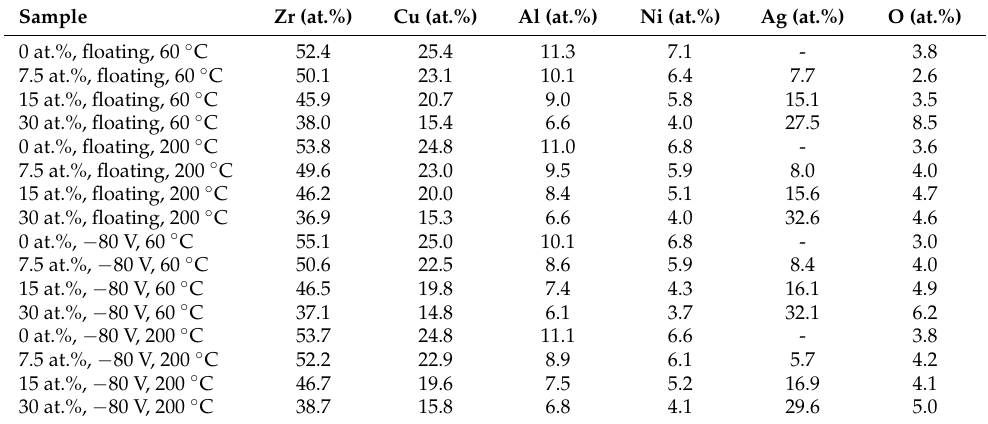
Table 2. Chemical composition of all films measured by EDX (calibrated with ion beam analysis data). Sample Zr (at.%) Cu (at.%) Al (at.%) Ni (at.%) Ag (at.%) O (at.%) 0 at.%, floating, 60 ◦